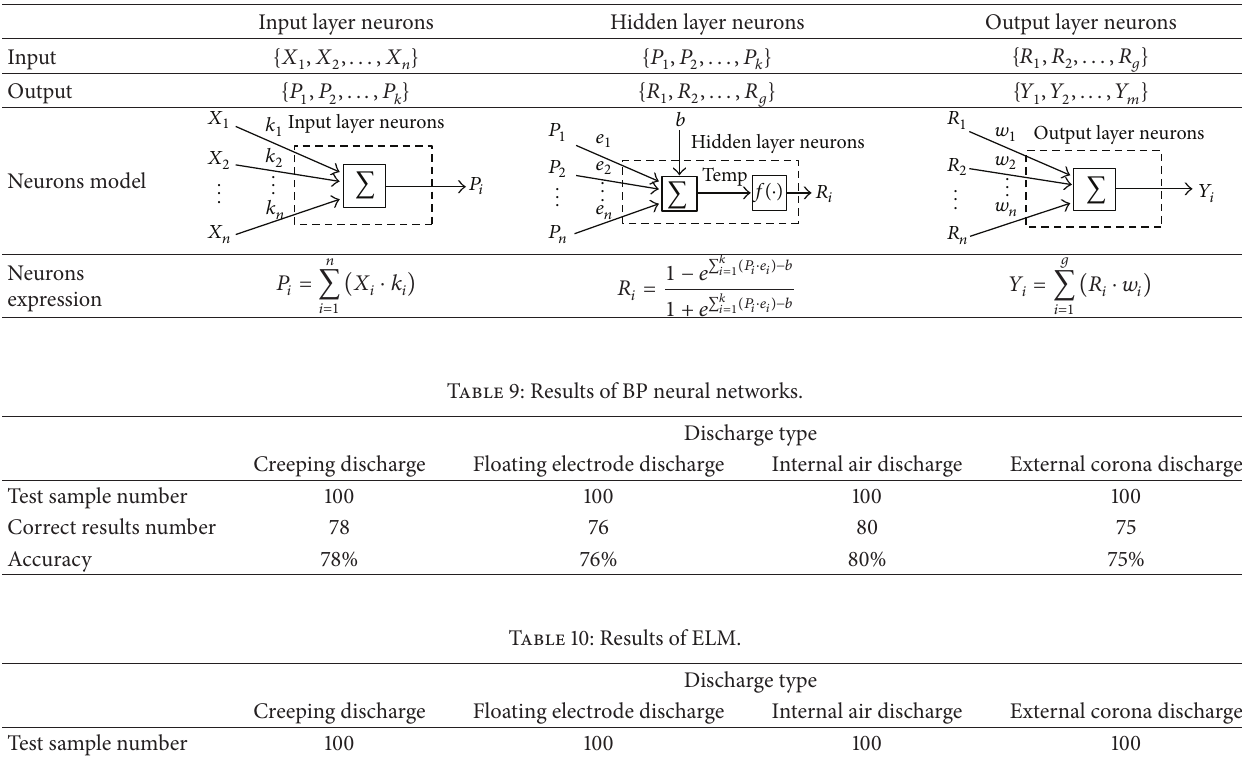
Table 8: Detailed expression of BP neural networks.